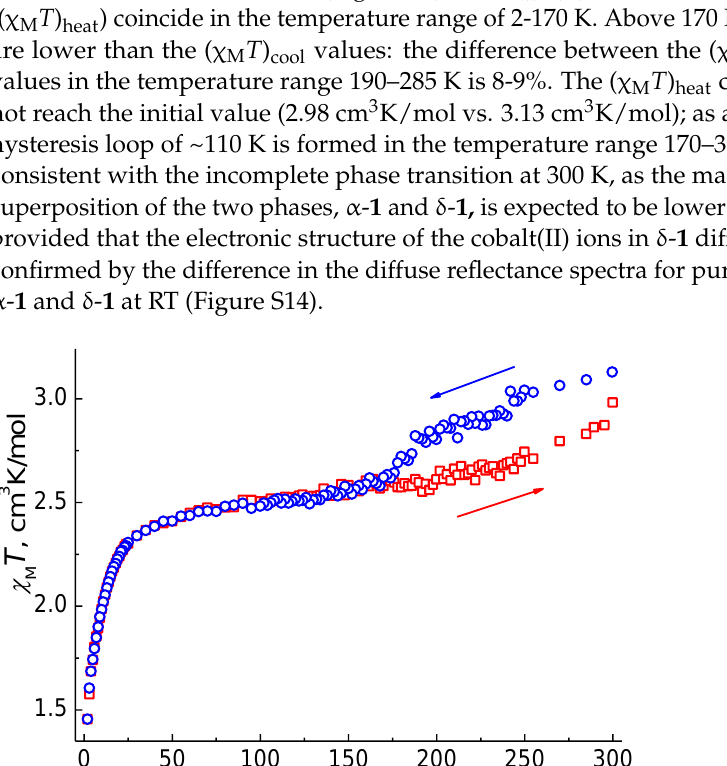
Figure 7. Temperature dependences of χ M T for 1 measured at H DC = 0.1 T (blue — cooling in the range 300 – 2 K; red — heating in the range 2 – 300 K).